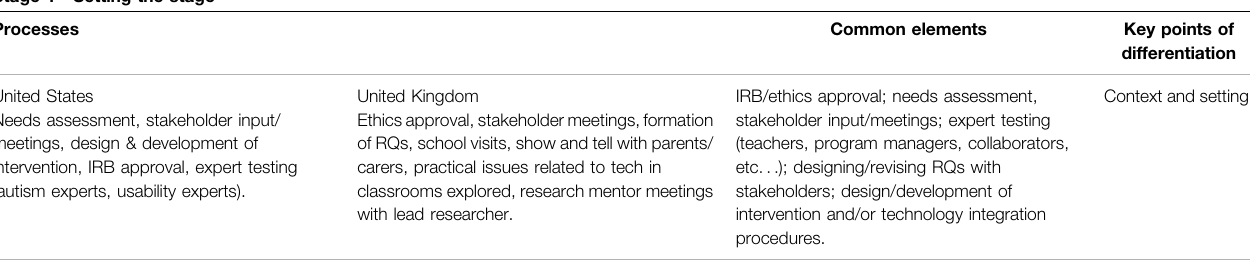
Key points of differentiation